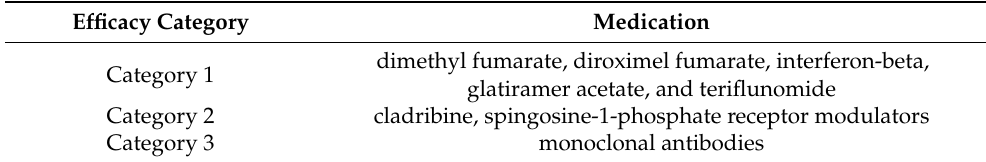
Table 1. Classification of MS medication based on German National Guidelines